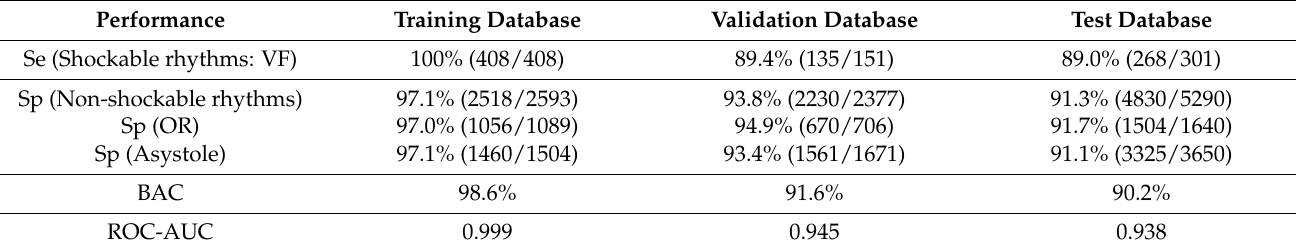
Figure 7. ROC curves of CNN3-CC-ECG network for the validation and test databases. The threshold of the ROC operating point for the validation database (black ‘o’ mark) was computed at BAC → max. The same threshold was applied to report the final performance for the test database (red ‘o’ mark). Table 5. Performance of CNN3-CC-ECG network for analysis of ECG rhythms during